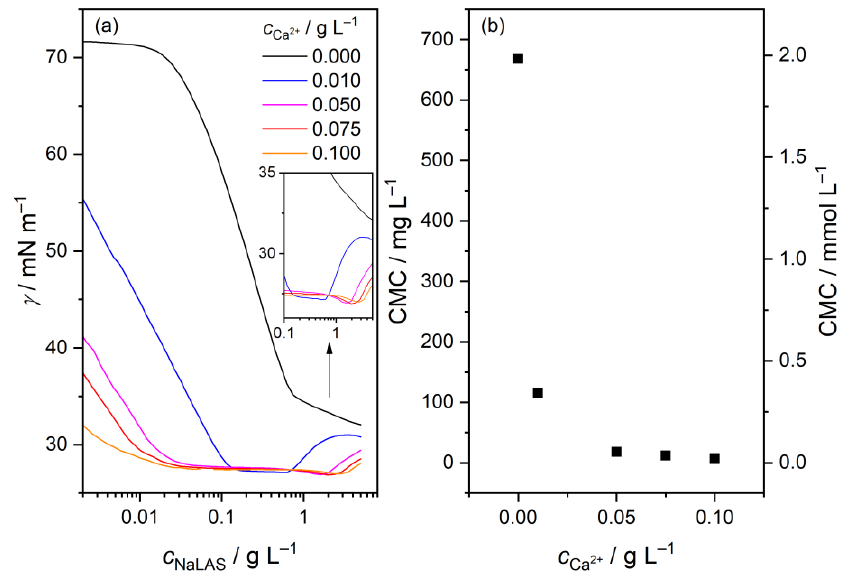
Figure 2. ( a ) Surface tension ( γ ) as a function of sodium linear alkylbenzene sulfonate (NaLAS) concentration, in the presence of CaCl 2 . Inset: zoomed region showing the onset of the increase in γ ; ( b ) Critical micelle concentration (CMC) in mg L – 1 (left axis) and in mmol L – 1 (right axis), as a function of Ca 2+ -ion concentration. Experimental conditions: c Ca2+ = 0 – 0.1 g L – 1 , c NaLAS = 0.002 – 5.00 g L – 1 , T = (25.0 ± 0.1) °C.